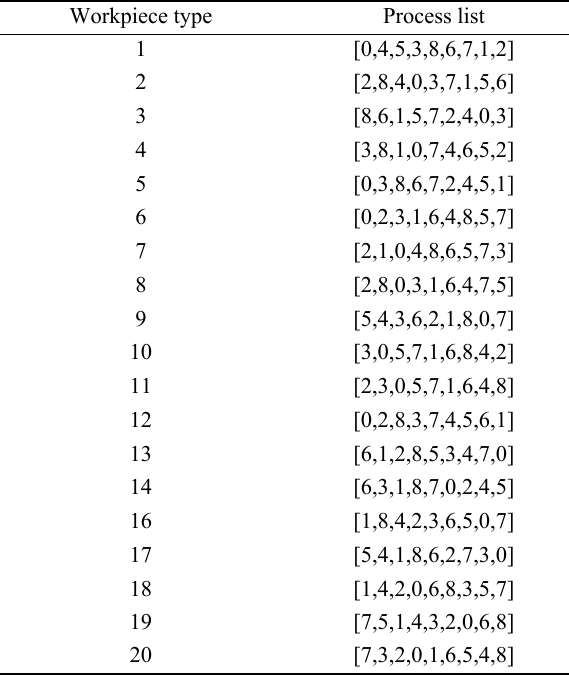
Table 5 Process information of different